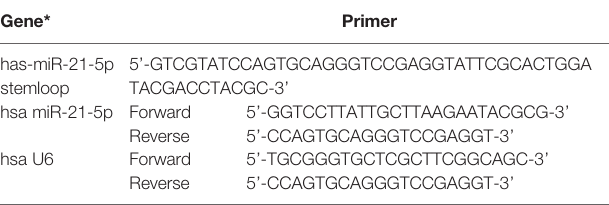
TABLE 1 | Primers sequences used in